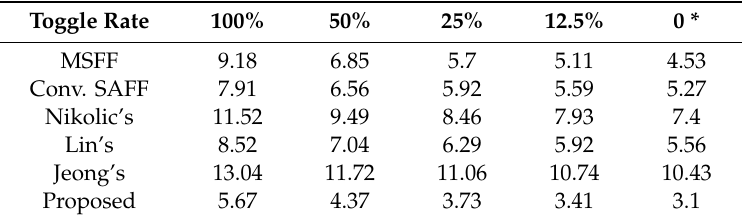
Table 2. Power consumption ( µ W) of the flip-flops under di ff erent input data toggle rates at the speed of 500